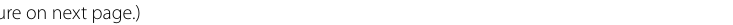
546 6 nm, λ em. 590 nm; FITC: λ exc. 470 20 nm, λ em. 525 25 nm). = ± ≥ = ± = ± SD of n ± =